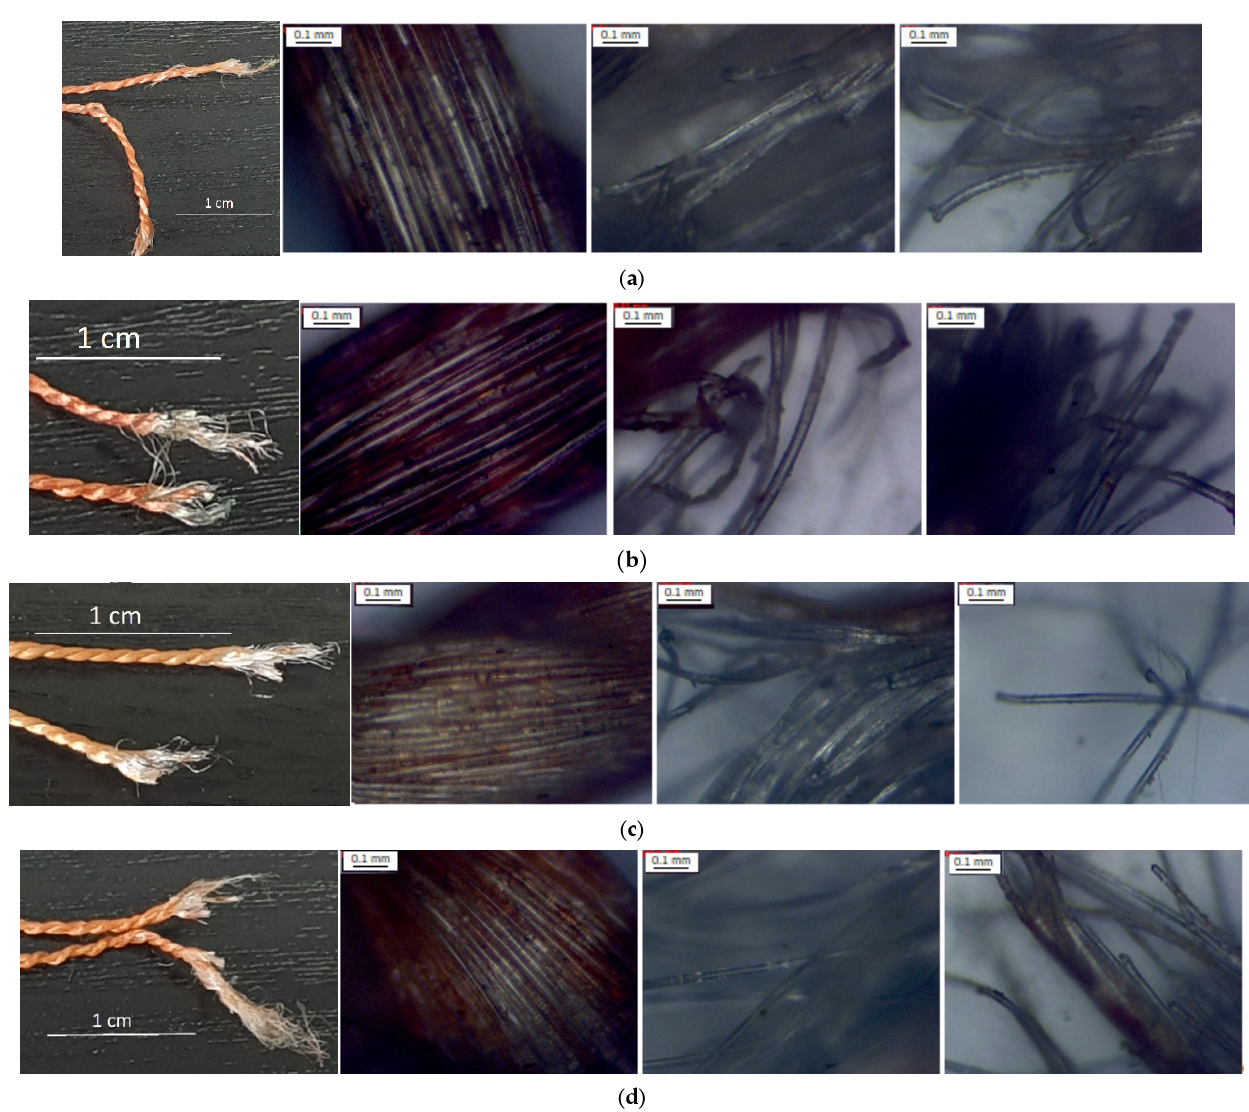
Figure 11. Broken ends of ( a ) cord I, ( b ) cord II, ( c ) cord III and ( d ) cord IV; from left: real photo, microscopic photo of undamaged structure and inside damage area. Broken ends of single